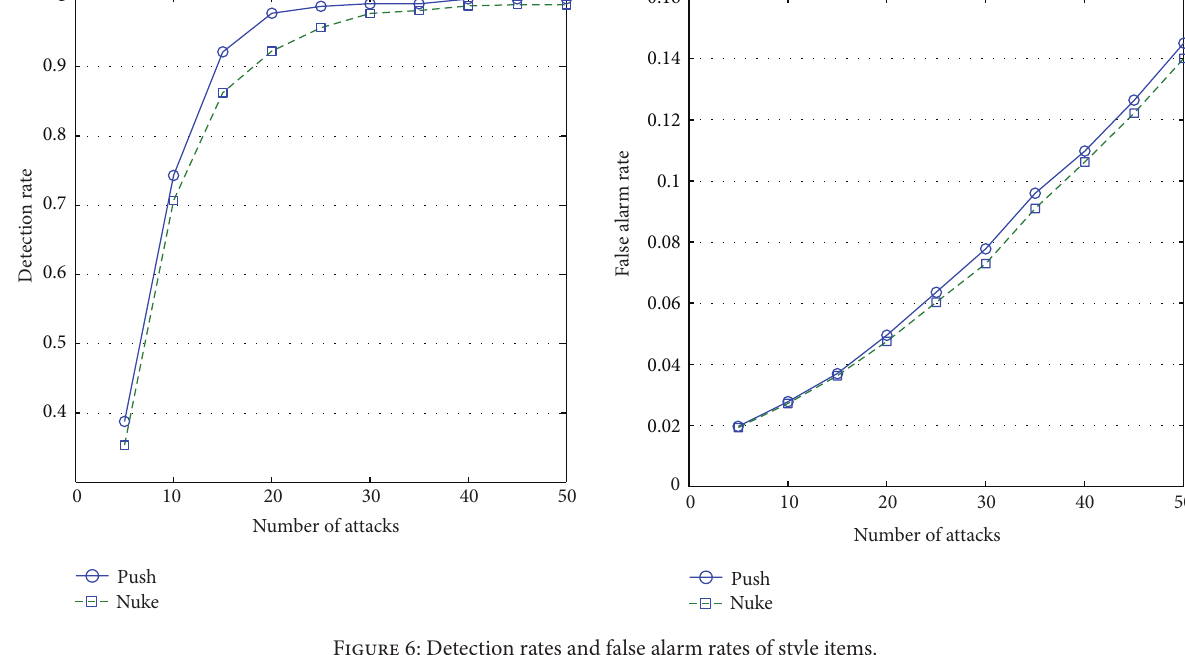
Figure 6: Detection rates and false alarm rates of style items.